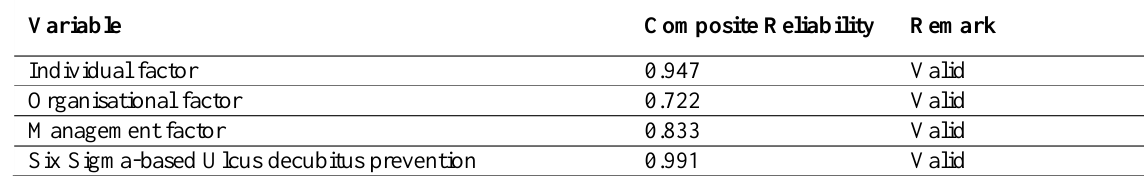
Table 4. Variable Reliability Results of individual, organisational, and management factors toward Six Sigma -based Ulcus Decubitus prevention based on Six Sigma on Unexpected Events (KTD) in the Inpatient Room